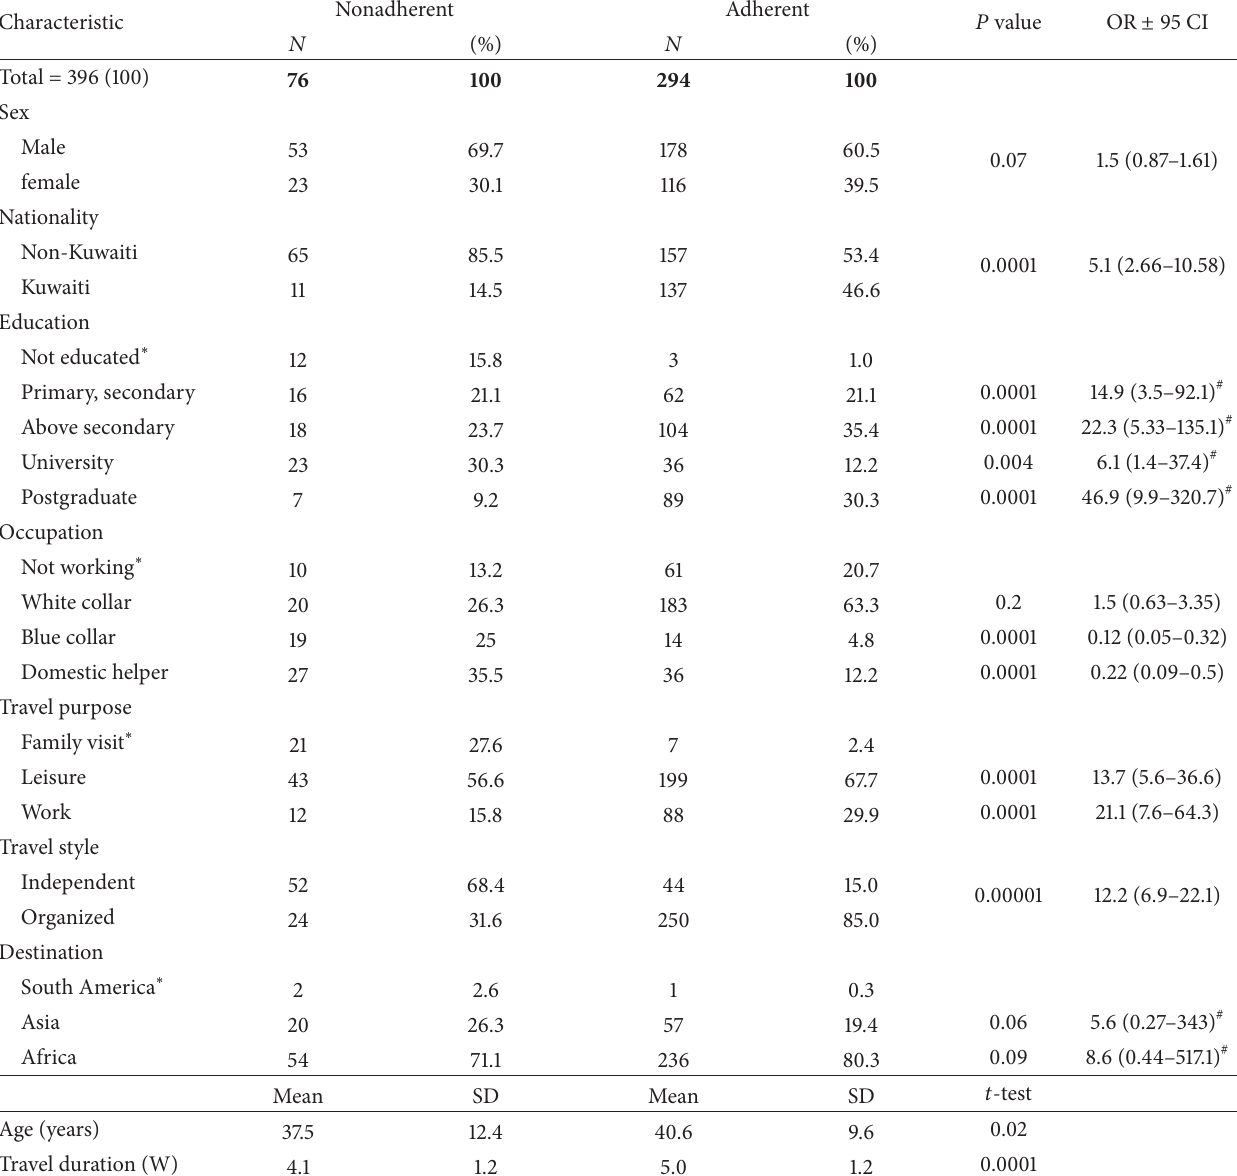
Table 4: Univariate analysis of doxycycline group between adherent and nonadherent individuals.